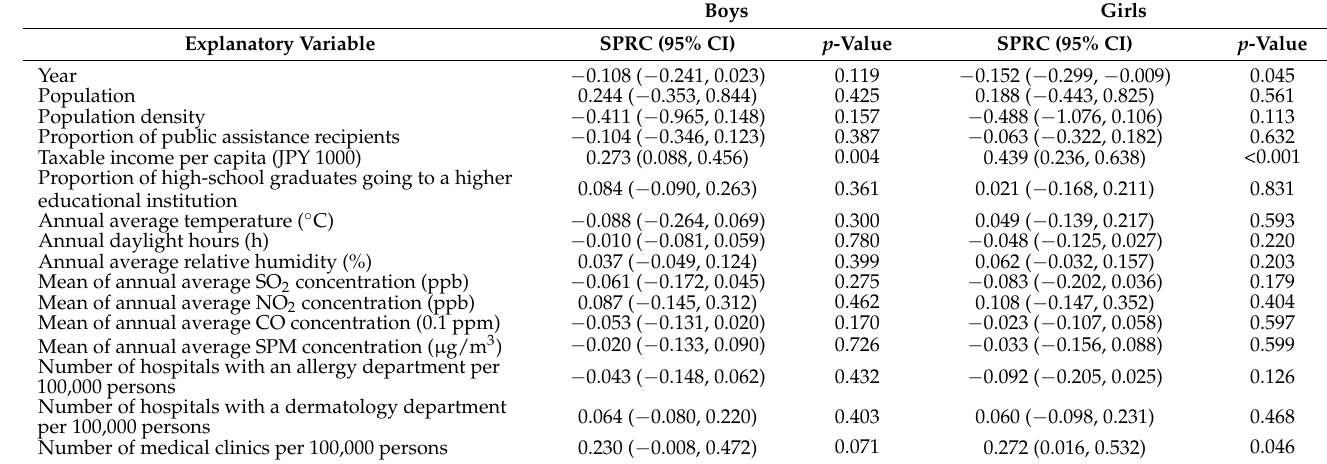
Table 5. Results of regression